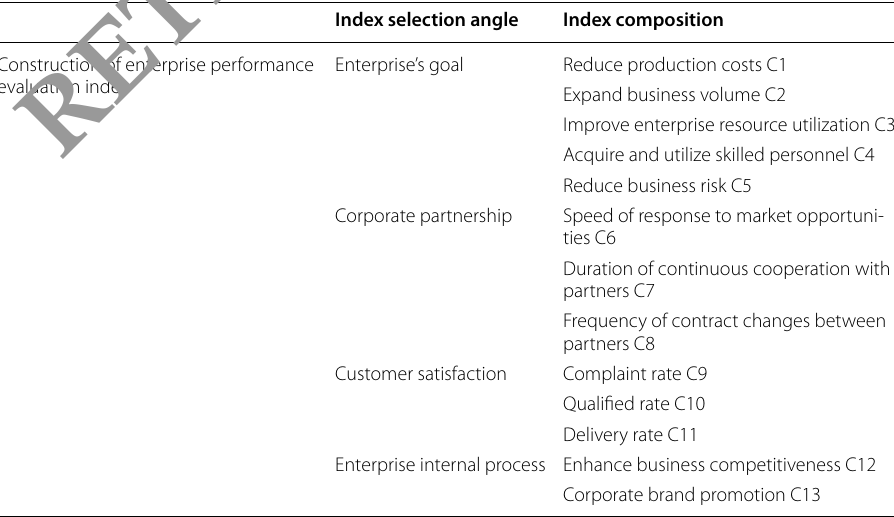
Table 1 The composition of theoretical indexes of enterprise performance evaluation Index selection angle Index